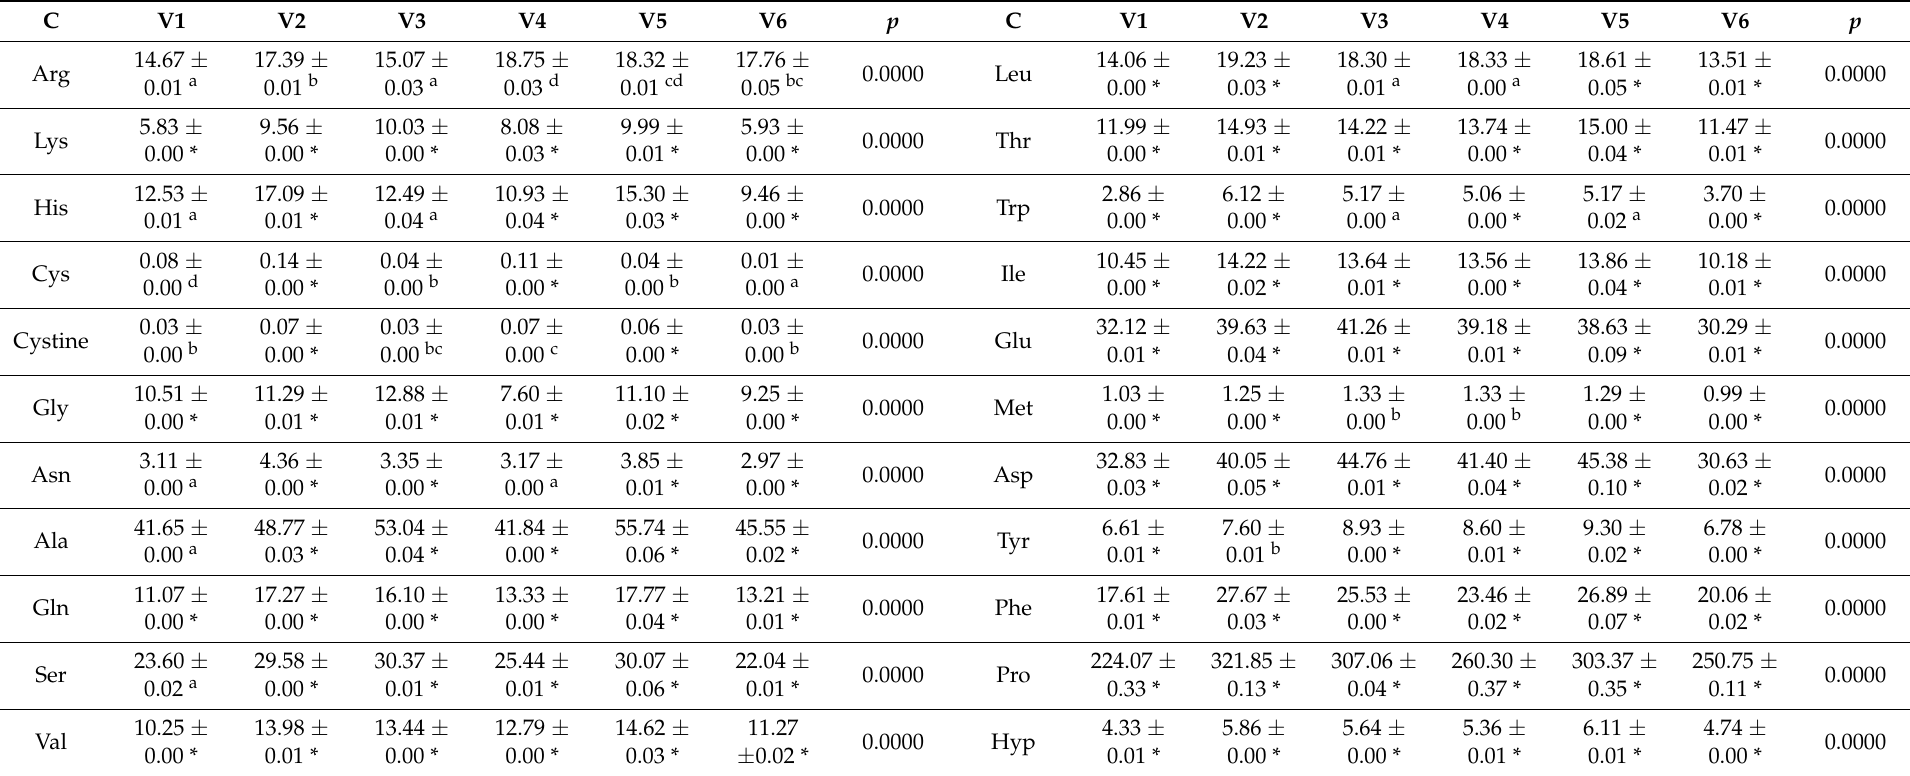
Table 2. Evaluation of some amino acid concentrations in resultant Sauvignon blanc wines